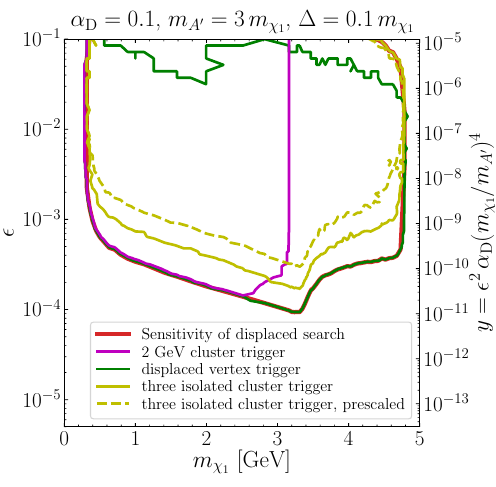
Figure 8 . Sensitivity of the displaced search, overlaid with the regions where the various triggers are e(cid:14)cient for an integrated luminosity of 50 ab (cid:0) 1 for m A